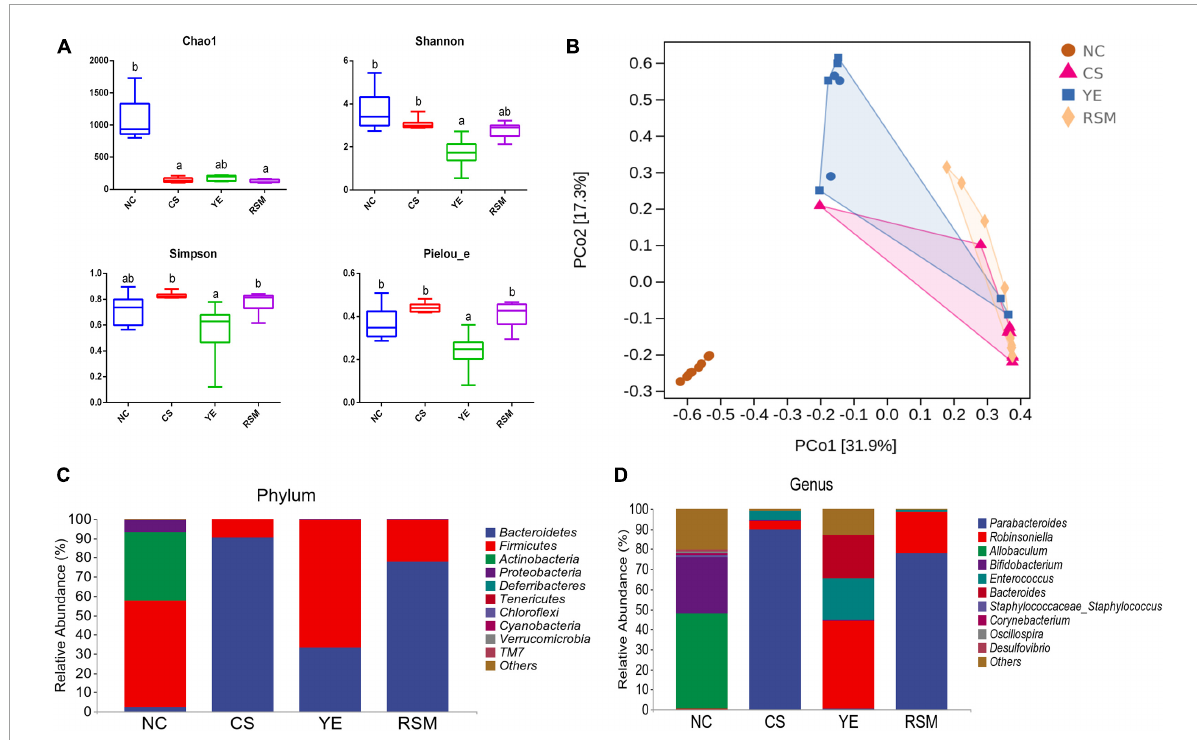
FIGURE4 Effects of two kinds of algal oil on the intestinal microbiota of CS induced mice. (A) Alpha diversity indexes of the gut microbiota. (B) PCoA diagram based on the bray-Curtis distances of beta diversity of the gut microbiota. (C) Gut microbial compositions at phylum level (only top 10 abundant phylum were included). (D) Gut microbial compositions at genus level (only top 10 abundant genus were presented). Data ( n = 9 per group) are expressed as mean ± SEM; groups with different letters statistically differ. Groups with the same letter are considered to have no significant differences, groups with different letters are significantly different from each other ( P <